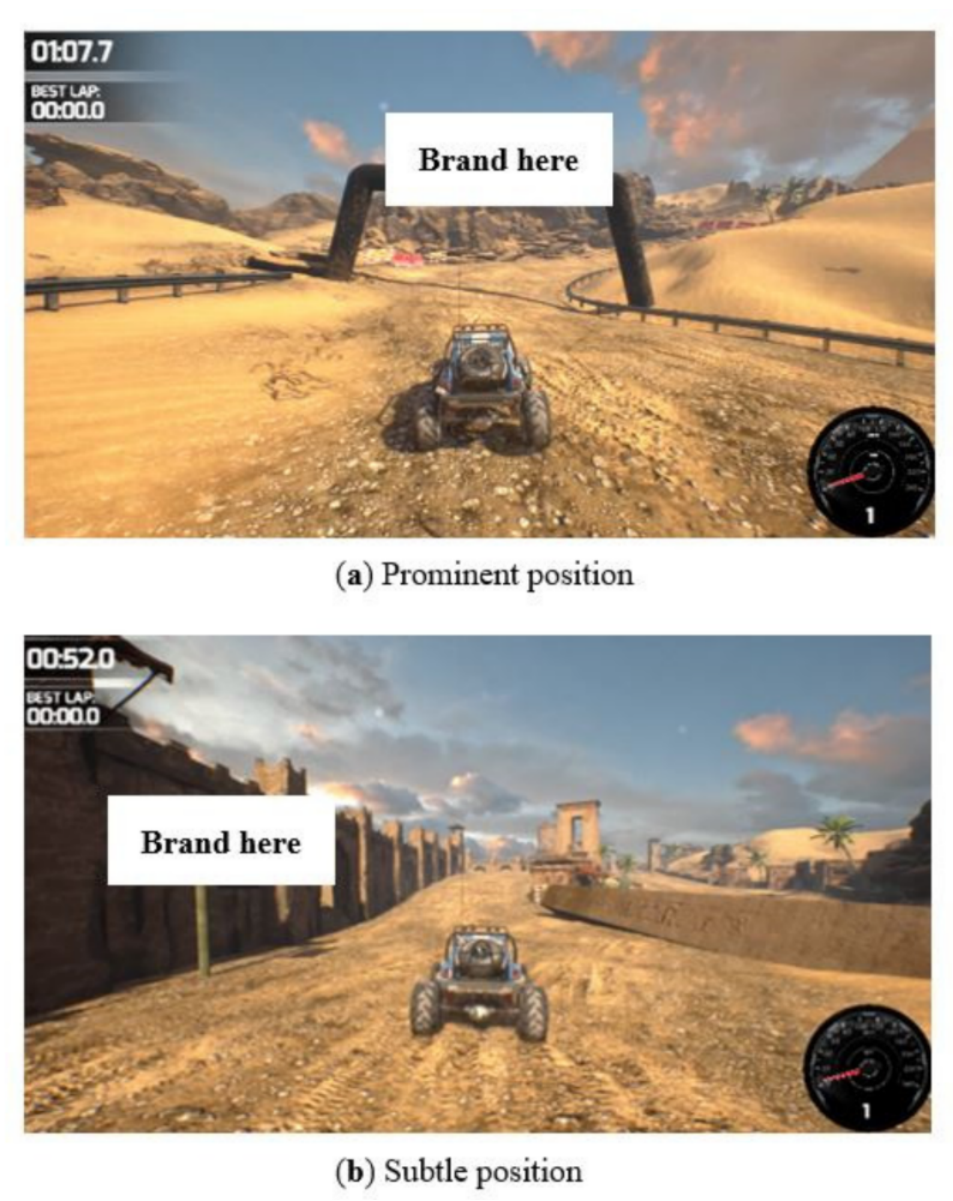
Figure 1. Videogame used in the main study. Examples of brand placements: ( a ) prominent position, ( b ) subtle